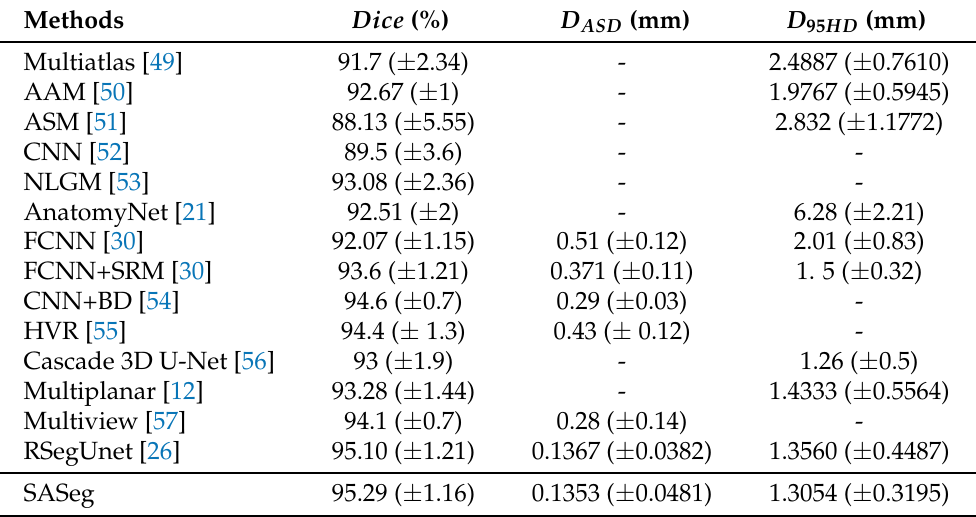
Table 5. Quantitative comparison of the segmentation performance on the PDDCA dataset between the proposed method and the state-of-the-art